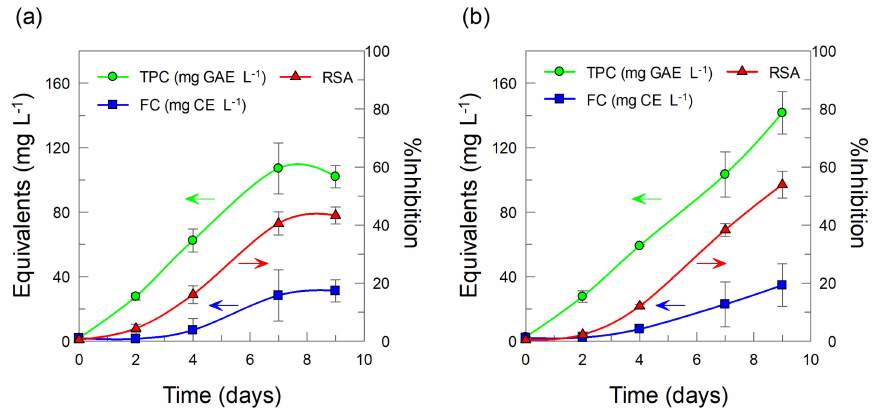
Figure 5. Extracellular total phenolic content (TPC, - • -) and flavonoid content (FC, - (cid:4) -) and extracellular radical scavenging activity (RSA, - (cid:78) -) of extracts from B. × houghtonii suspension cultured cells (BHSCC) treated with M– β –CD ( a ) and HP– β –CD ( b ); [CD] = 50 mM at T = 25 ± 1 ◦ C. Values are given as the mean ± SD of triplicates. The solid lines are drawn to aid the eye.